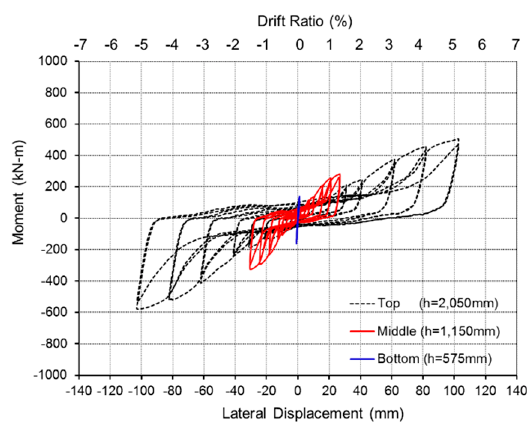
Figure 28. Load–displacement hysteresis curve of SP-H.